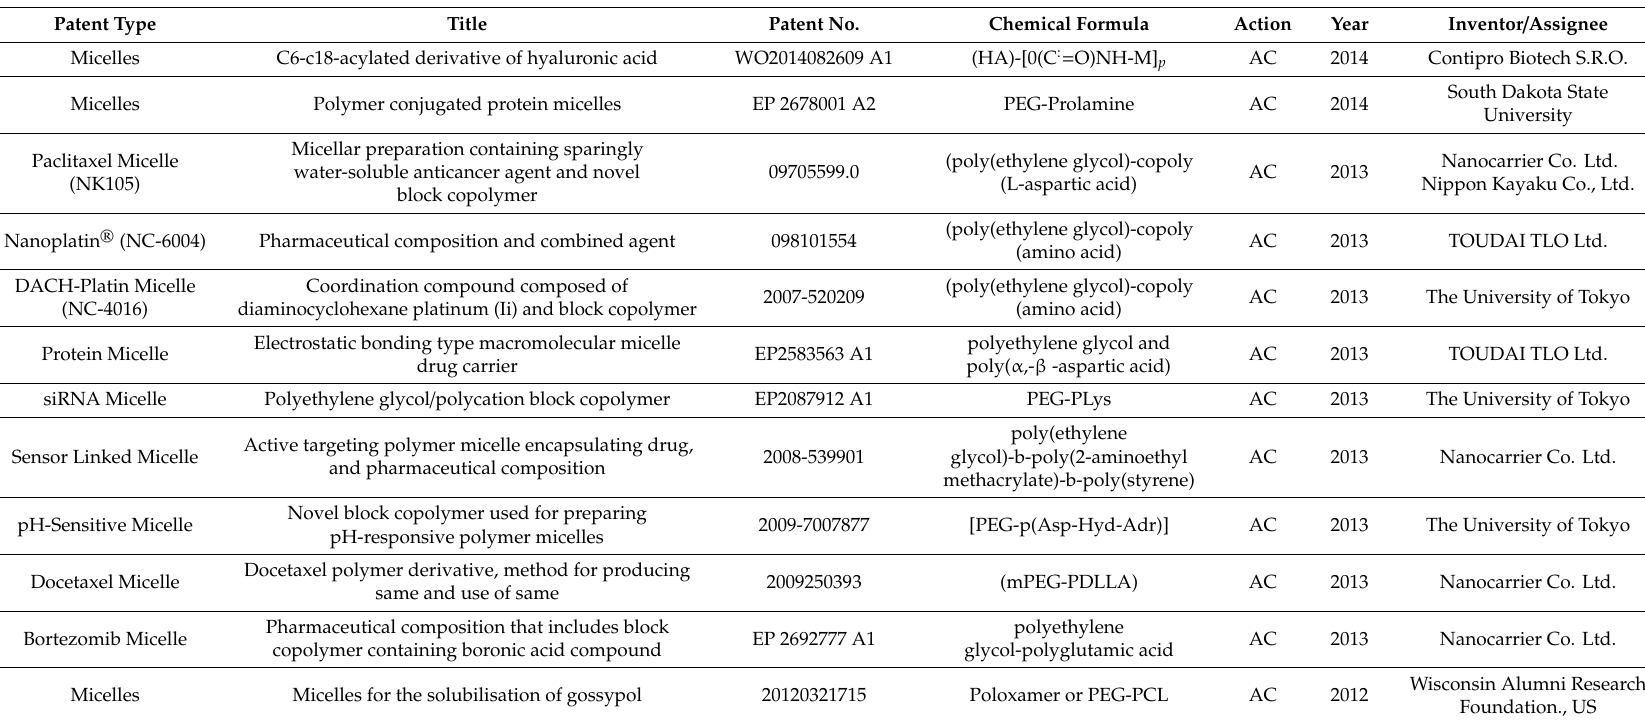
Table 5. Micellar patents issued in the area of cancer drug delivery (Adapted and modified from Mishra et al.